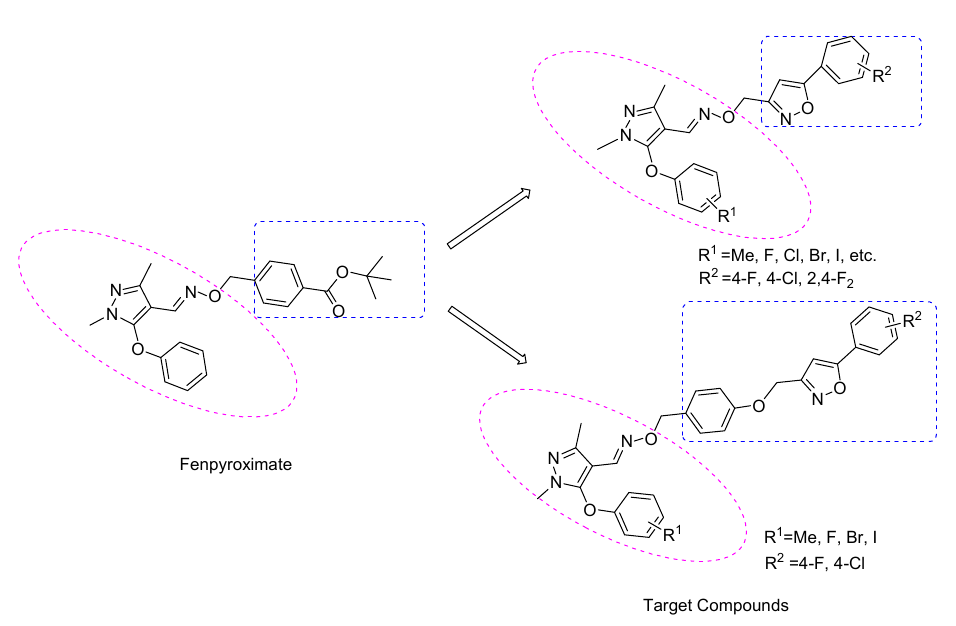
Figure 1. The design of the target molecules.